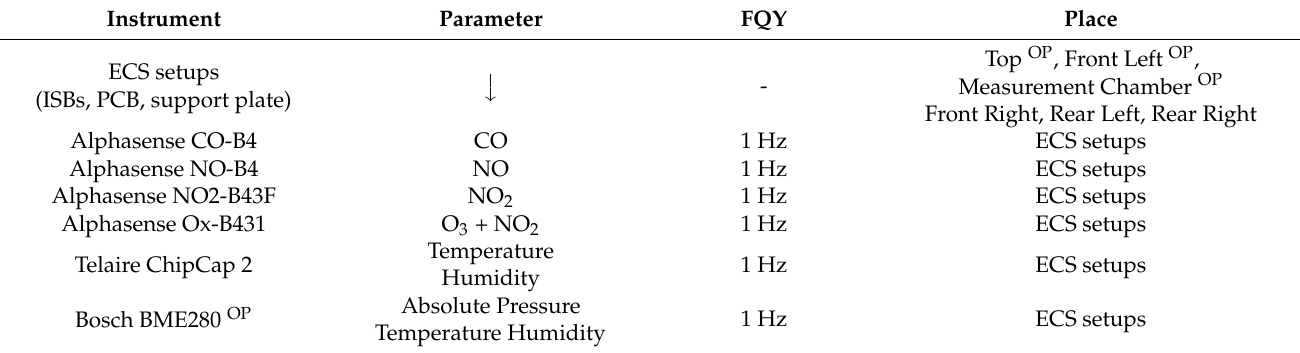
Table 4. Instruments for trace gas measurements on the UAV. Six ECS setups are mounted in different places on and inside the UAV. Each setup includes the listed sensors. Additionally, a POM is mounted inside the UAV for ozone measurements. ISB: Individual Sensor Board (Alphasense); PCB: Printed Circuit